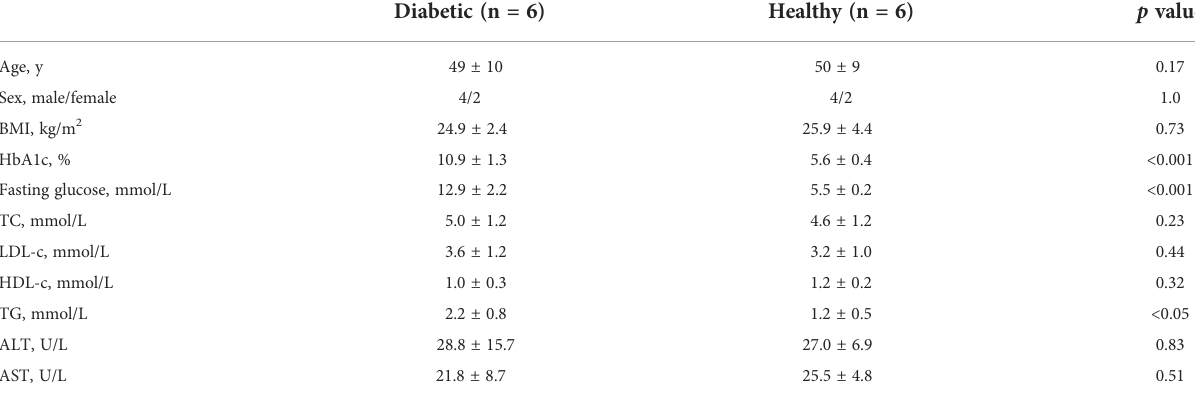
TABLE 1 Clinical and laboratory characteristics of diabetic patients and non-diabetic healthy controls in Study